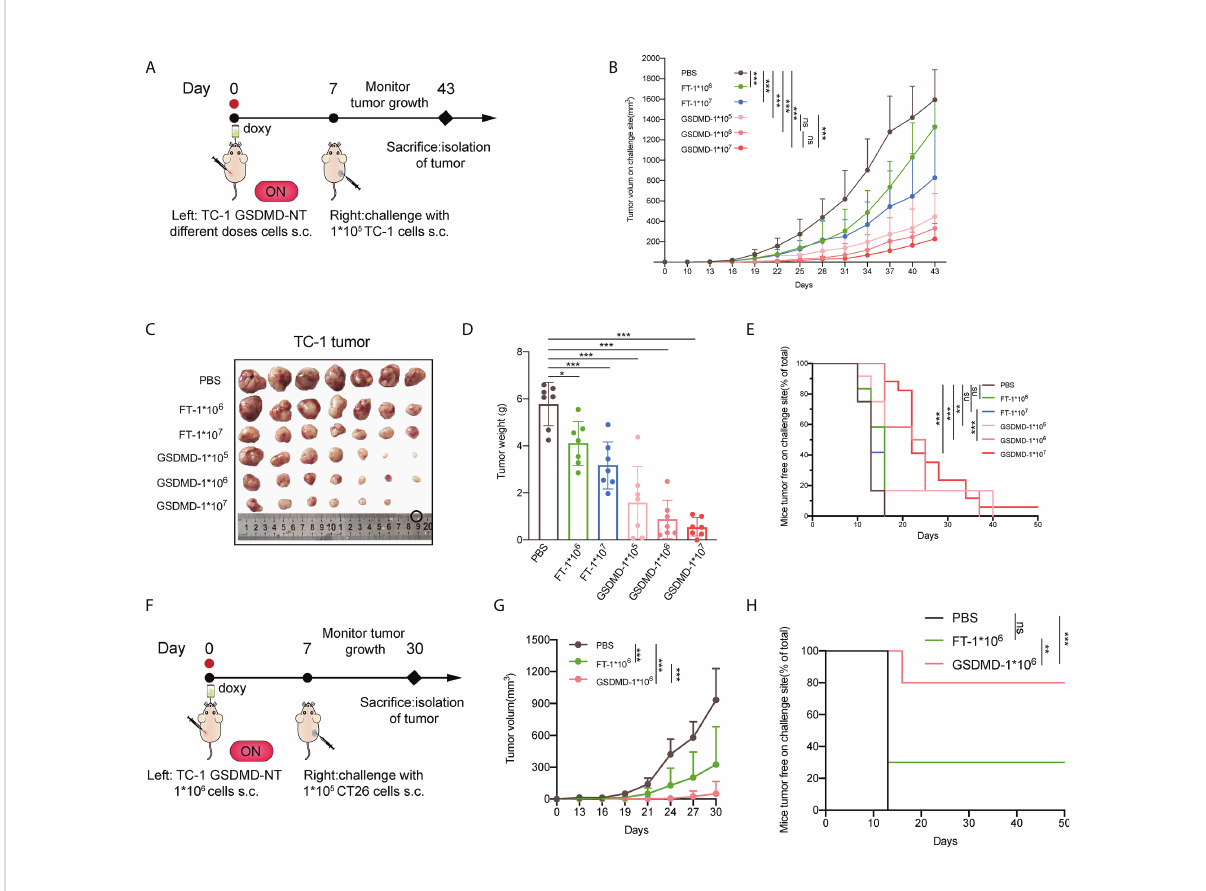
FIGURE 5 Preventive immunization with the novel pyroptosis induction-based tumor cell vaccine signi fi cantly inhibits the growth of grafted tumors in mice. (A) The protocol of the preventive immunization strategy for evaluating the potency of the immunity elicited by the pyroptotic TC-1 cells against the challenge of homogenous tumors in C57 mice (n=12). (B) Tumor growth curves by group (n=12). The repeated freeze-thaw lysis of tumor cells (FT cells) and PBS were used to replace the pyroptotic cells as blank controls. (C) The size of the isolated tumor mass (n=7). (D) The weight of the isolated tumor mass (n=7). (E) The percentage of the tumor-free mice (n=12). (F) The protocol of the preventive immunization strategy for evaluating the possible effects of pyroptotic TC-1 cells against the heterogeneous challenge of CT26 tumors in BALB/c mice (n=10). (G) Tumor growth curves by groups. (H) Percentage of the tumor-free mice. (B, D, G) Graph shows means ± SD, One-way ANOVA; (E, H) Log- rank test, * p value < 0.05, ** p value < 0.01, *** p value < 0.001, ns represents no signi fi